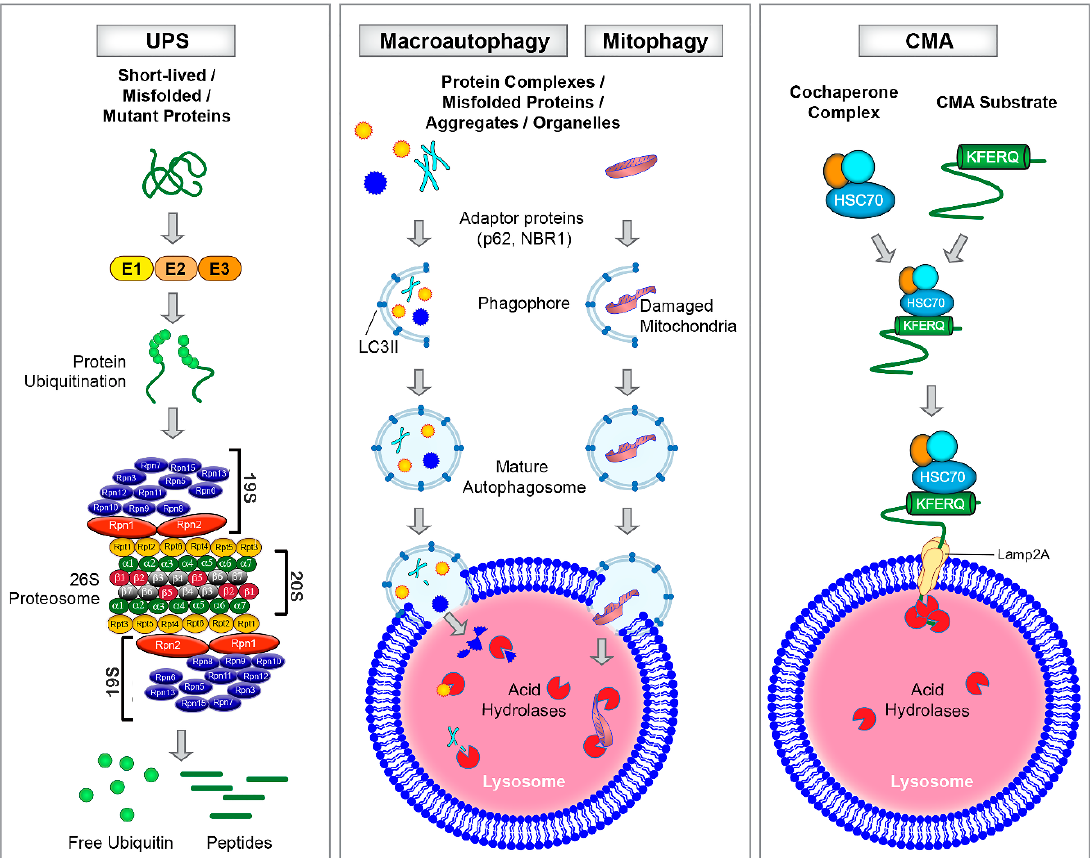
Figure 1. Schematic illustration of di ff erent types of protein degradation pathways. Left : Ubiquitin Proteasome System (UPS) employs three di ff erent enzymes, E1, E2 and E3 to target and tag proteins with four or more ubiquitin molecules. The 26S proteasome is a large protein complex that is comprised of approximately 33 di ff erent subunits which form the 20S proteolytic core particle capped by the 19S regulatory lid particle. The 20S core has six catalytic sites that cleave protein substrates. The ubiquitinated proteins are recognized and degraded by the 20S core particle into smaller peptides and the free ubiquitin is available for recycling. Middle : Macroautophagy and mitophagy require the formation of double-membrane vesicles called autophagosomes to engulf proteins and damaged mitochondria, for eventual fusion with, and degradation by, the lysosome. Right : Chaperone Mediated Autophagy (CMA) functions independently of autophagosomes and employs a co-chaperone complex, Hsc70, and the lysosomal receptor, LAMP2A, for the recognition and degradation of proteins bearing a unique KFERQ-like motif.